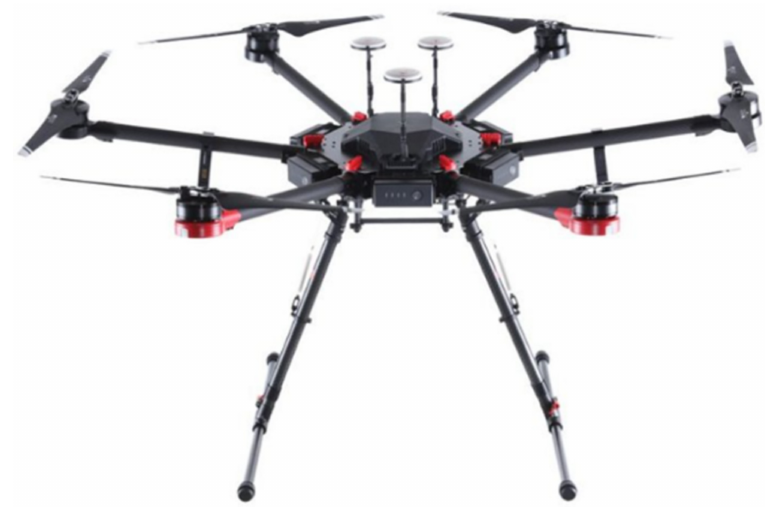
Figure 1. DJI MATRICE 600 PRO Hexacopter UAV (photo courtesy of